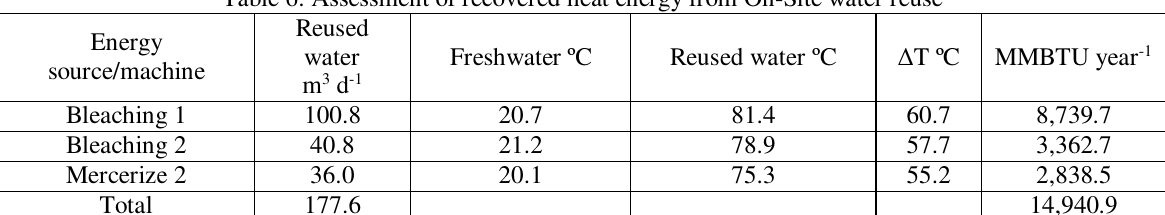
Table 6: Assessment of recovered heat energy from On-Site water reuse